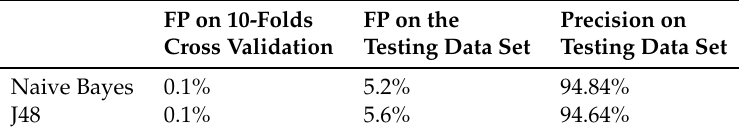
Table 8. False positive rate of J48 and Naive Bayes.